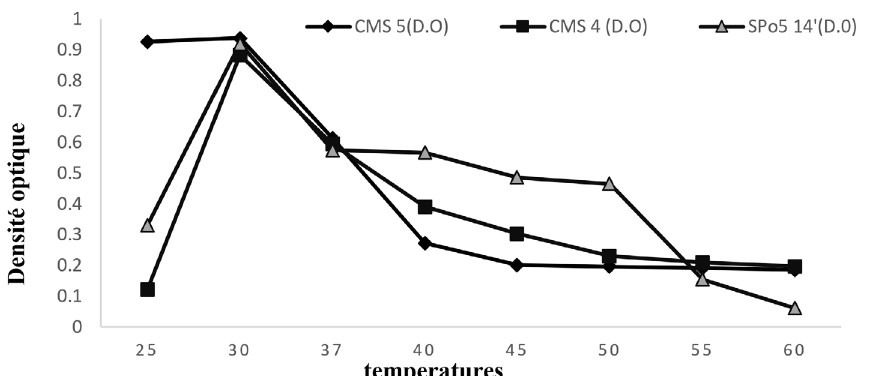
Fig. 2. Growth in CMS5 ( Bacillus subtilis ), CMS4 ( Bacillus sp.) and SPo5 14' ( Bacillus velenzensis ) as a function of temperature